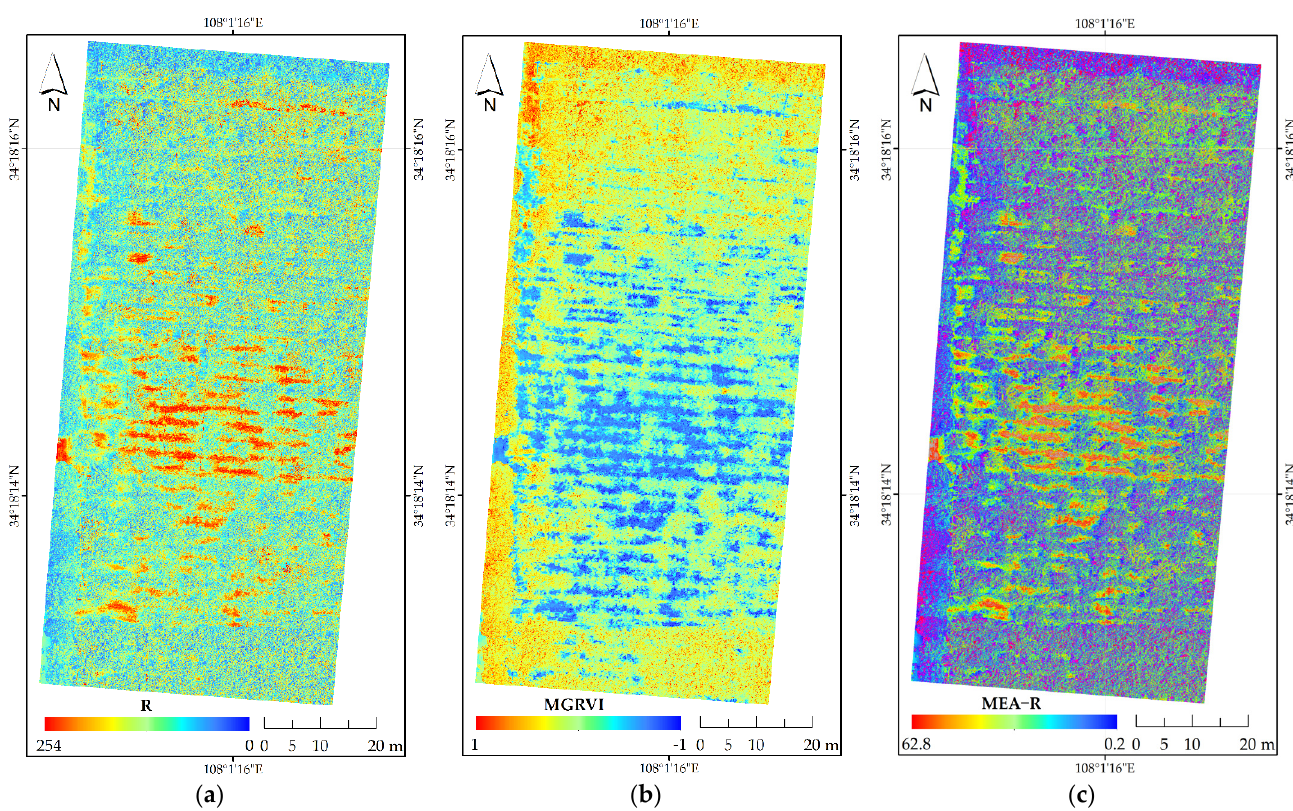
Figure 3. Part of the parameters analyzed in the study. ( a ) R (DN value of Red Channel) (IF); ( b ) MGRVI (Modified Green Red Vegetation Index); ( c ). MEA _ R (the mean of the red band).